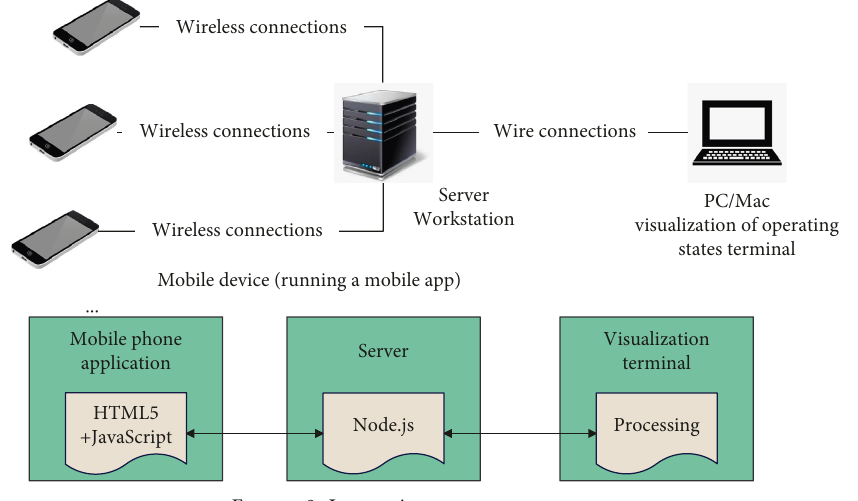
Figure 9: Interactive system